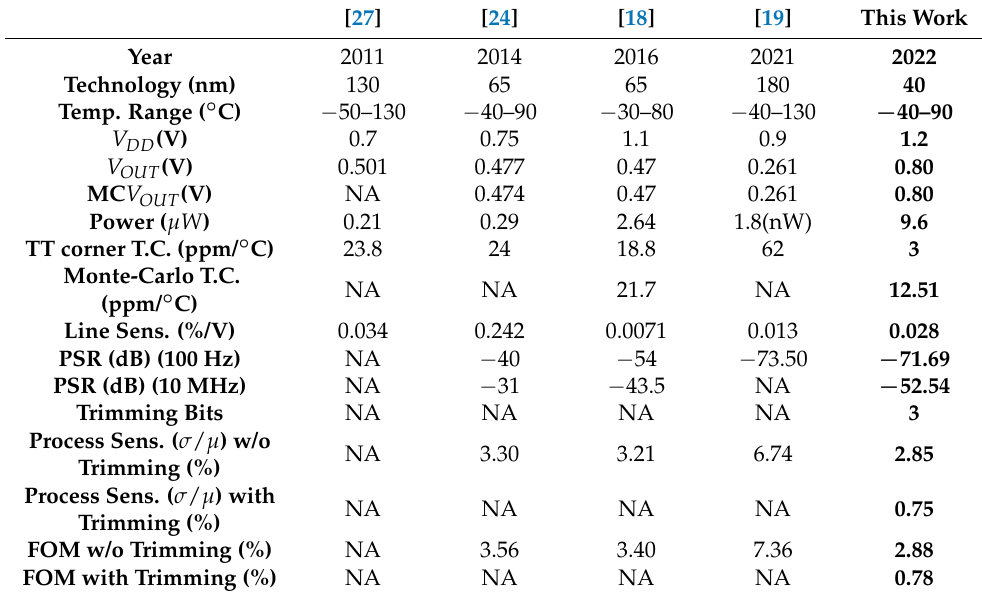
Table 6. The Performance Benchmarks Against Subthreshold MOSFET-Only Voltage